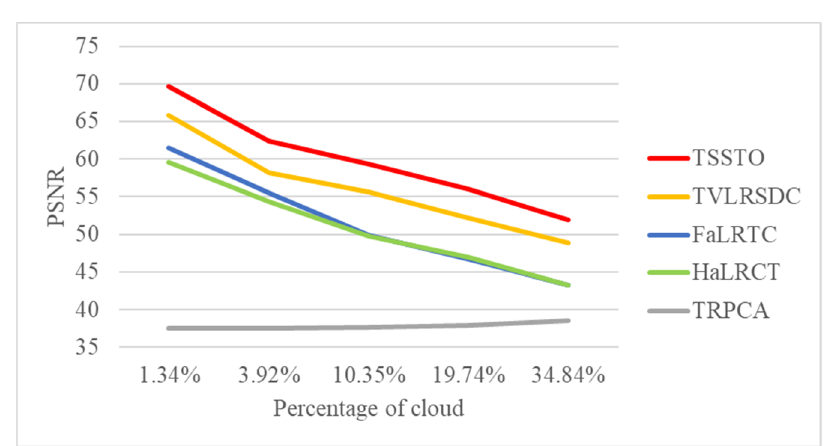
Figure 15. The PSNR values of the results with different methods and cloud sizes.